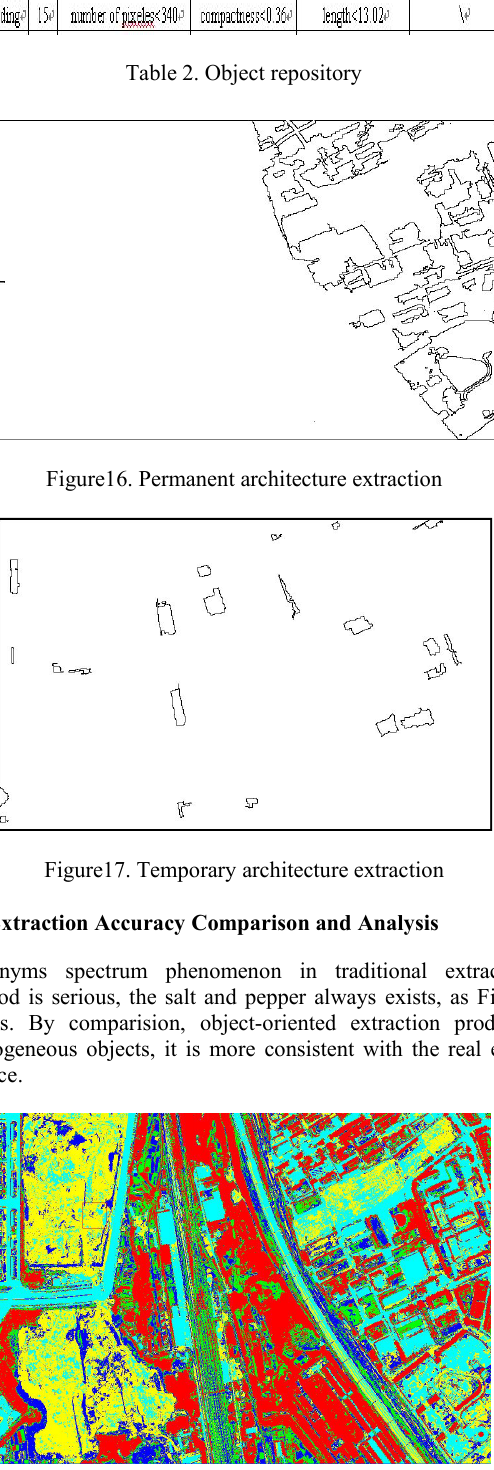
Figure18. K-means extraction result